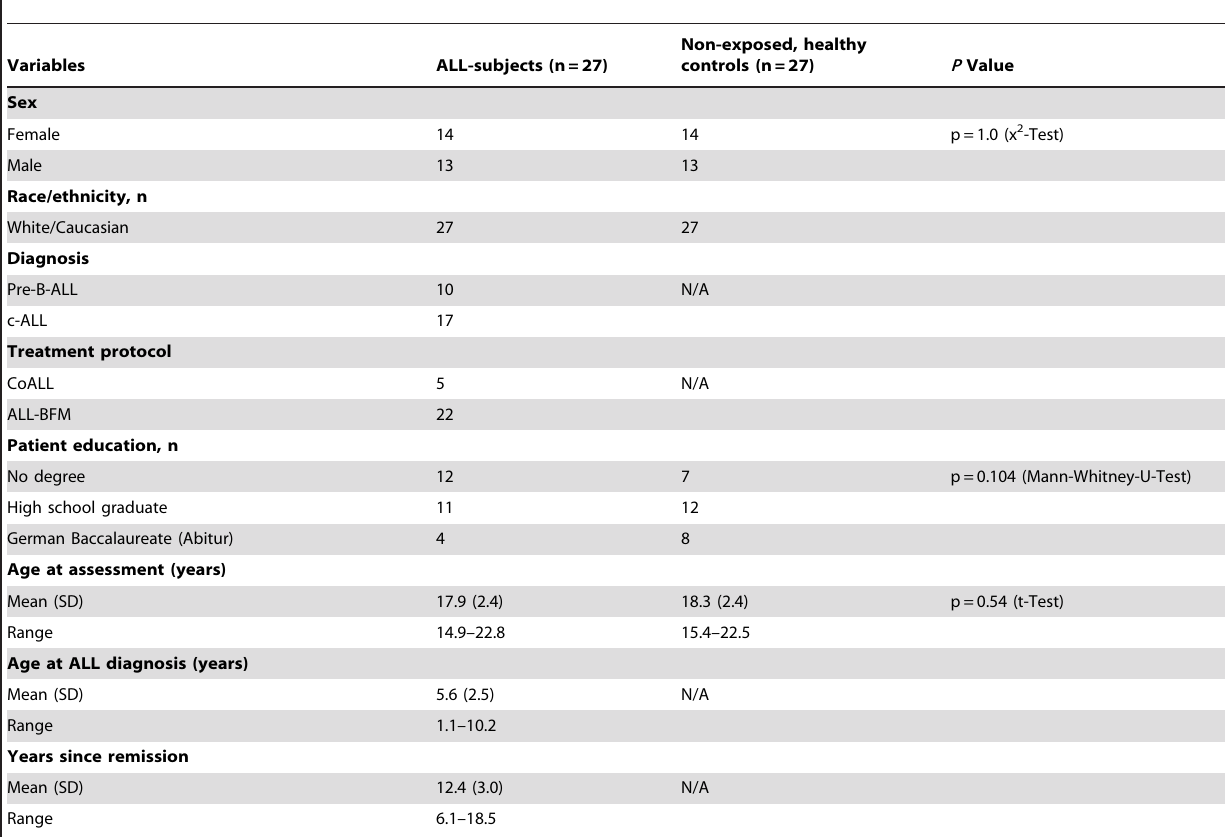
Table 1. Demographics of ALL-survivors and non-exposed, healthy controls (N/A= non applicable, SD=standard